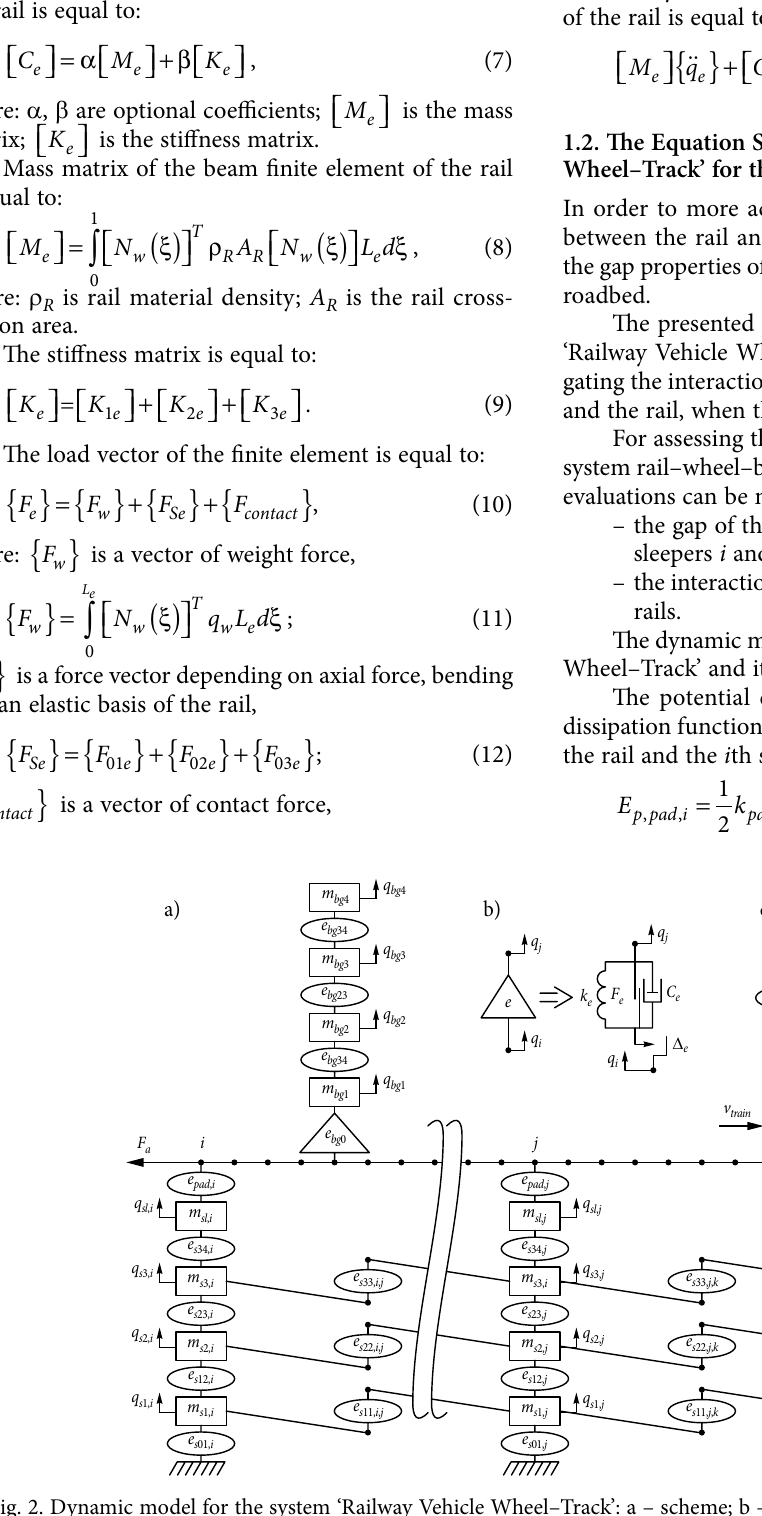
Fig. 2. Dynamic model for the system ‘Railway Vehicle Wheel–Track’: a – scheme; b – nonlinear elastic-damping